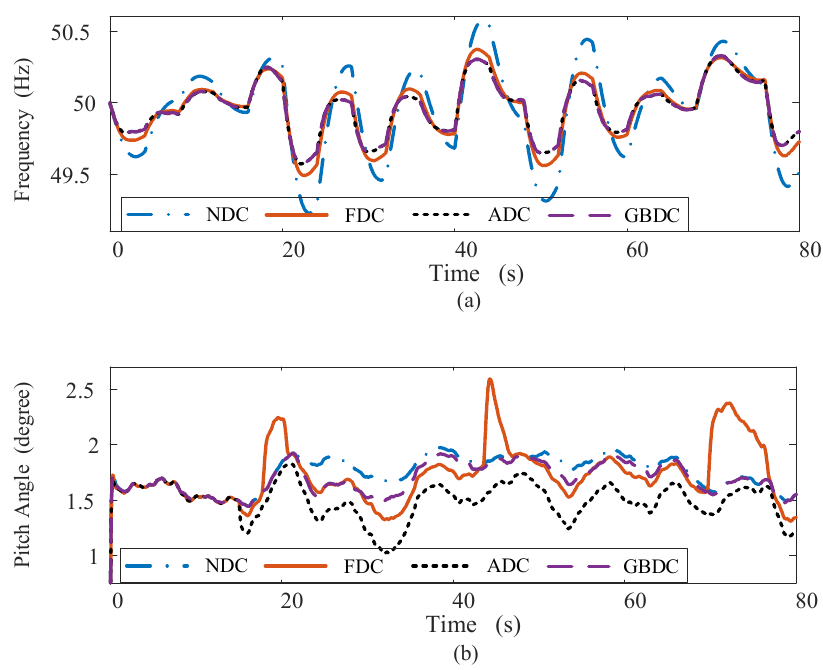
Figure 15. Simulation results of Case 4: ( a ) frequency; ( b ) pitch angle of WTG#1.